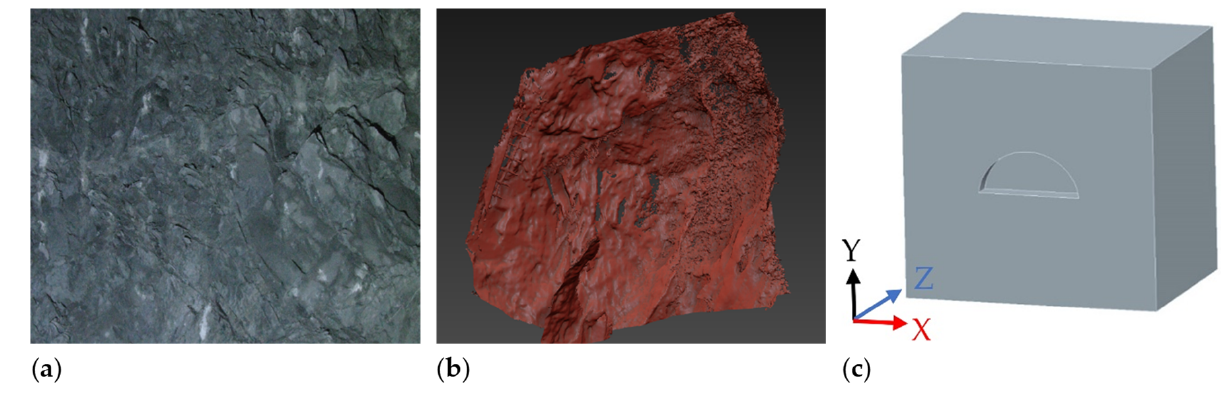
Figure 3. Monitoring section DK 150 + 876–DK 150 + 895 structural surface information: ( a ) visible light photo of the rock wall; ( b ) 3D scan of the rock wall; and ( c ) geometric model.